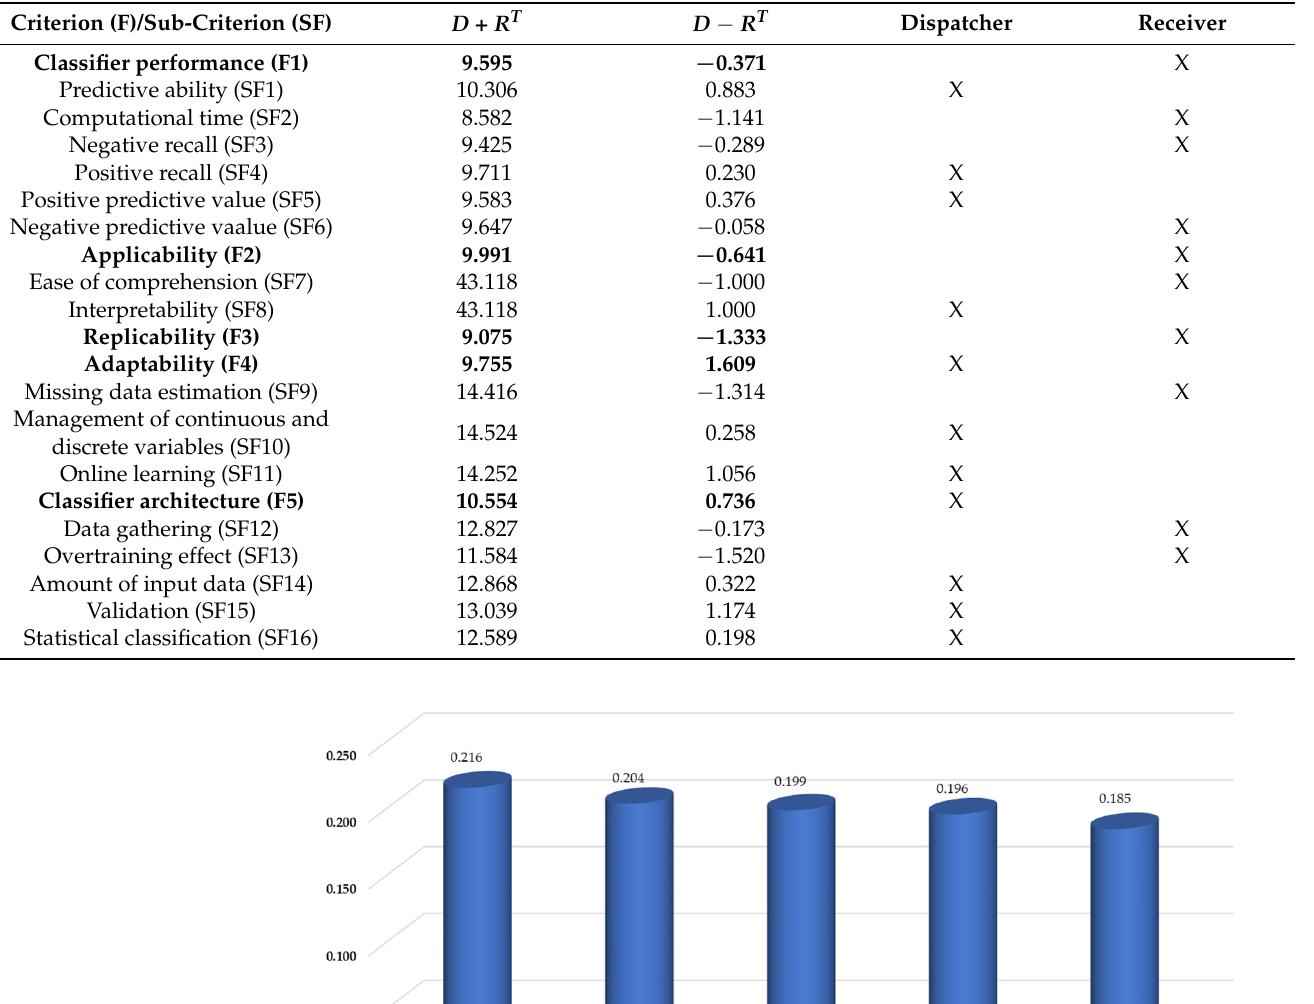
Table 3. Prominence and relation values within the classifier selection model.